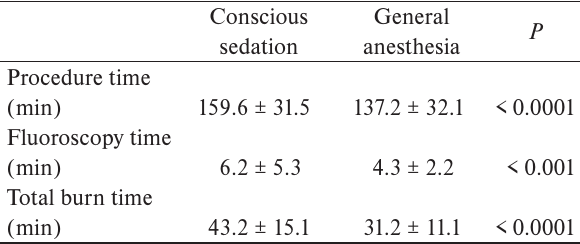
Table 3. Catheter ablation